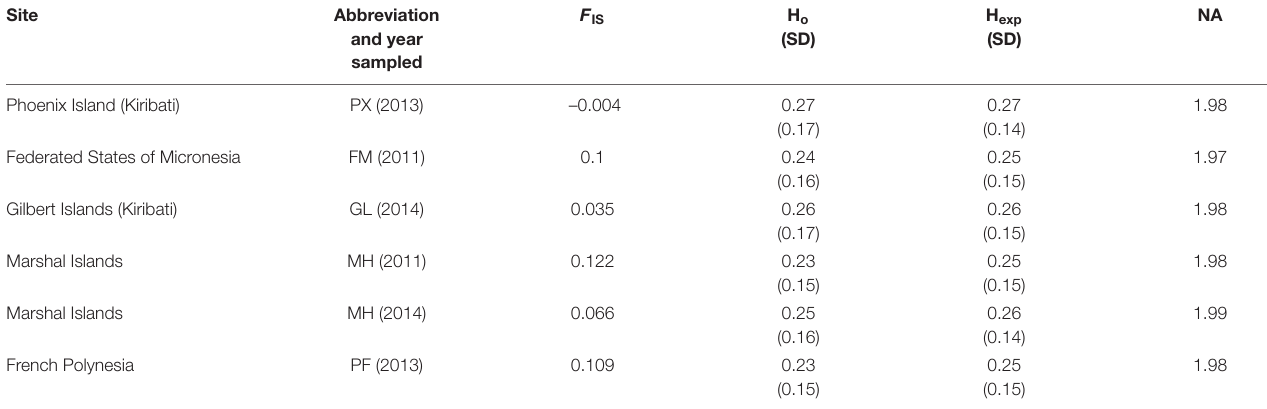
TABLE 2 | Bigeye tuna sampling information and genetic diversity indices.